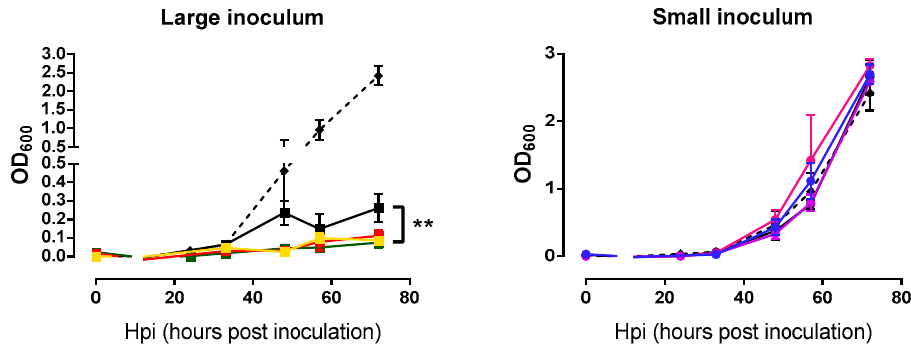
Figure 4. Bacterial growth curves of the founder and evolved lines. Founder: Black. Large inoculum: ( A ) Yellow, ( B ) red, ( C ) green. Small inoculum: ( D ) Blue, ( E ) purple, ( F ) pink. Dots show the average OD 600 at each time point and error bars indicate the SEM ( n = 3). Control without phage infection in dashed line. **: p <